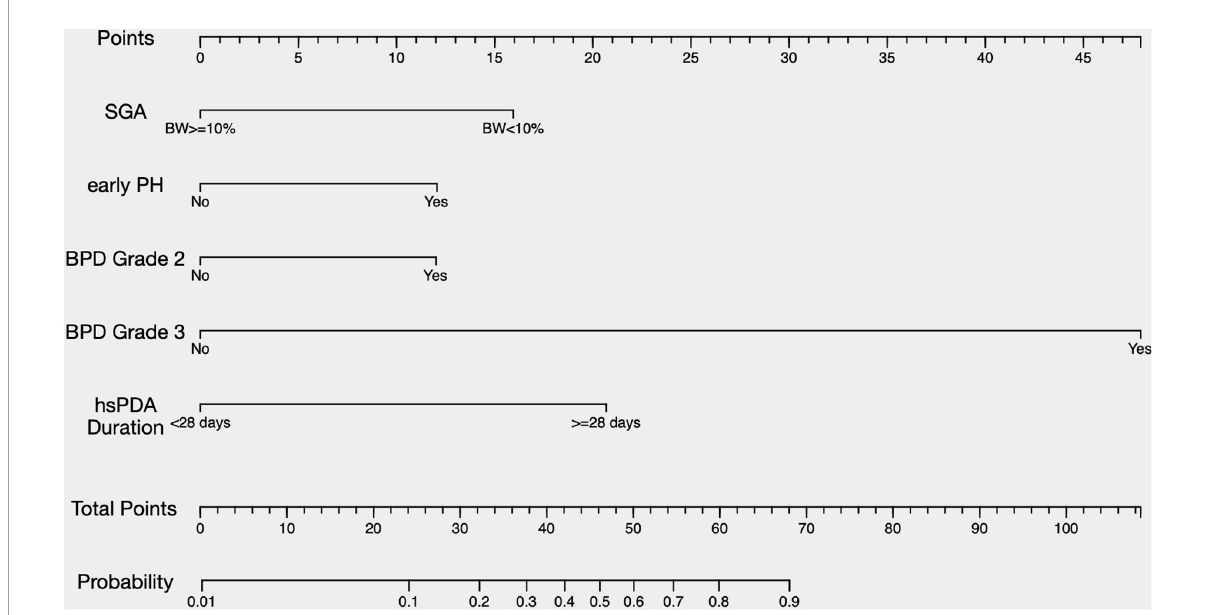
FIGURE2 A nomogram predicting the risk of BPD-PH. The value of each of variable was given a score on the point scale axis. A total score could be easily calculated by adding each single score and, by projecting the total score to the lower total point scale, we were able to estimate the probability of BPD-PH. SGA, small for gestational age; PH, pulmonary hypertension; BPD, bronchopulmonary dysplasia; hsPDA, hemodynamically significant patent ductus arteriosus.